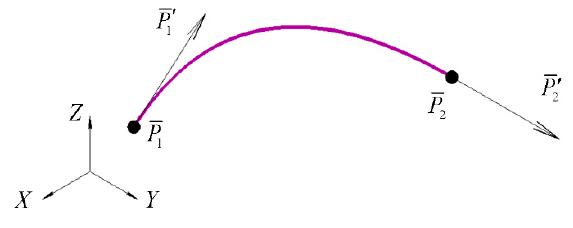
Figure 1. Hermitian cubic segment.